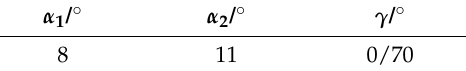
Figure 21. Beam Configuration of Transmitting and Receiving Arrays. Table 2. Position Parameters of a Bistatic Array.